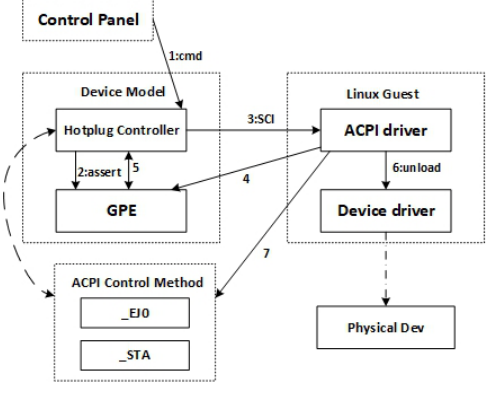
Figure 5. Virtual ACPI Hotplug